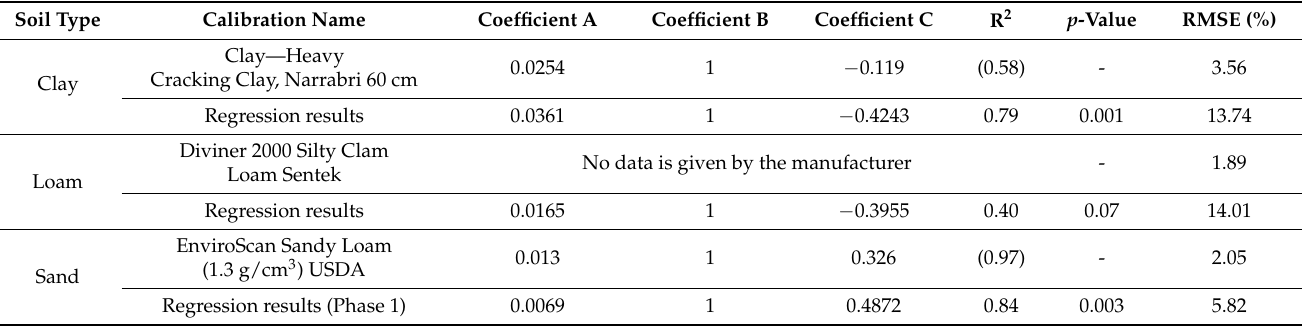
Table 5. Statistical metrics associated with coefficients of various calibration equations (Field calibration—Phase 1). Soil